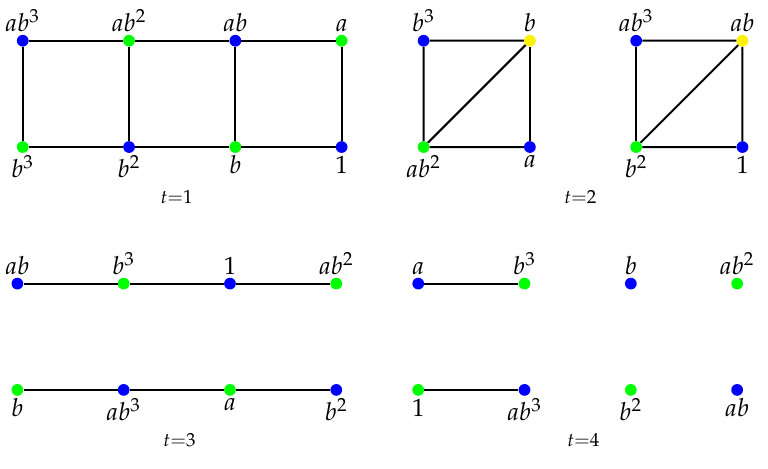
Figure 1. Some t -graphs of Z 2 × Z 4 , D 4 , and Q 8